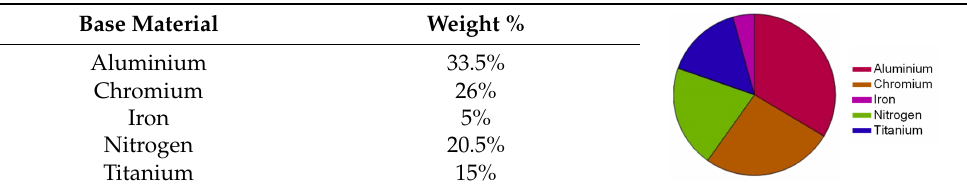
Table 4. Coating chemical composition.